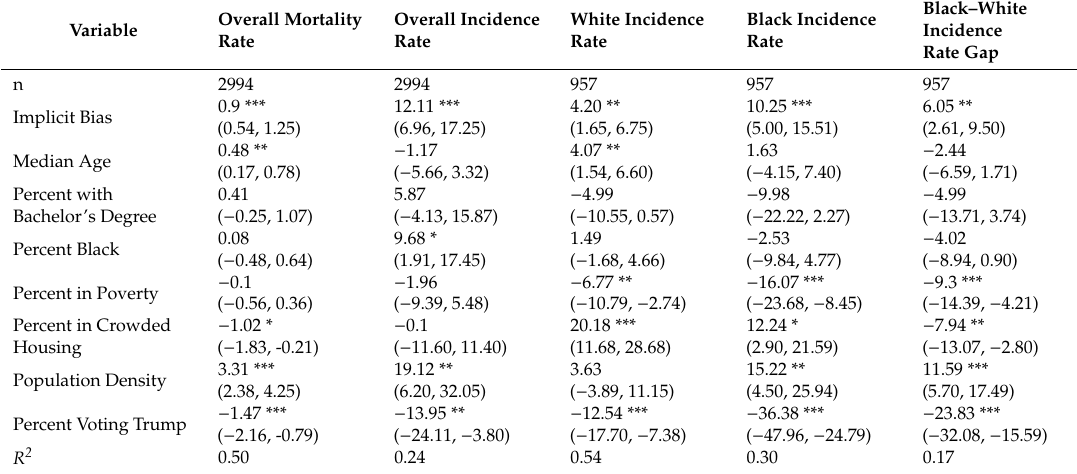
Table A4. Predicted shift in COVID-19 rates associated with a one standard deviation increase in county-level implicit bias (adjusted for other predictors), per 10,000 individuals in the county.